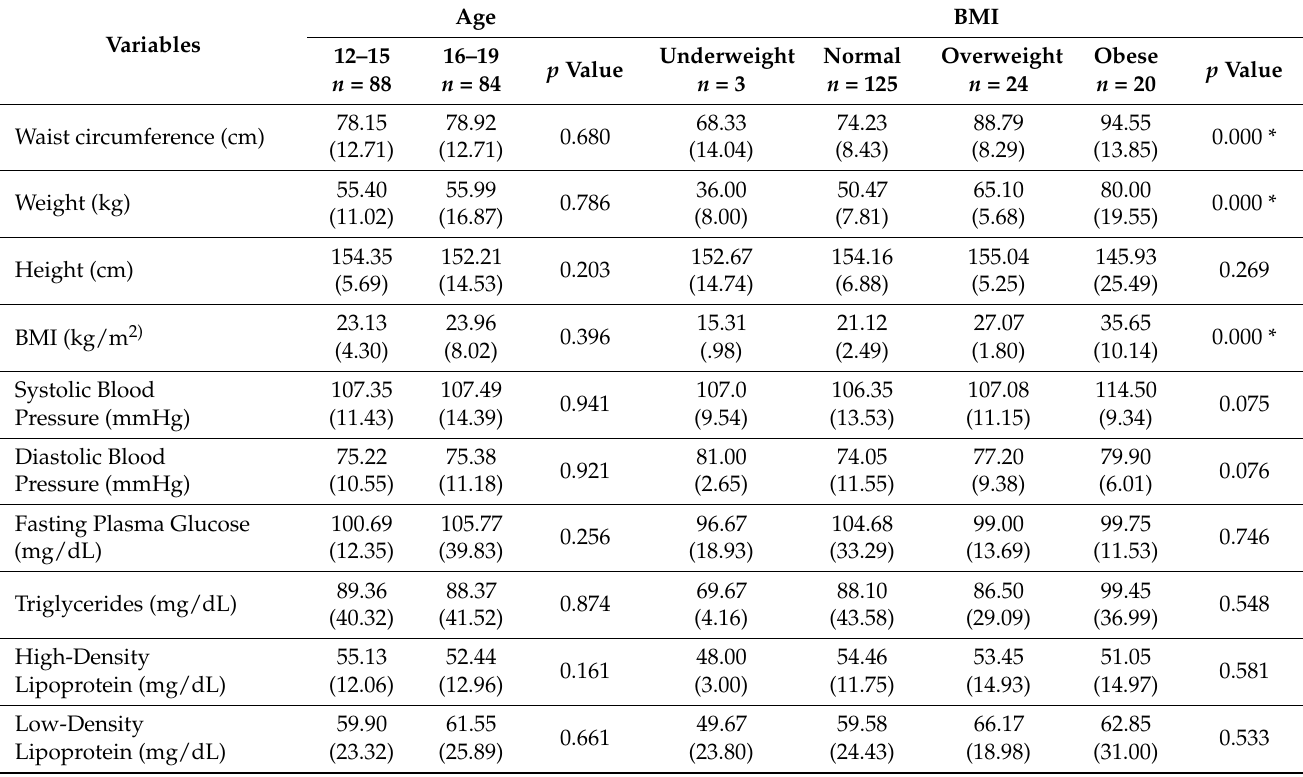
Table 1. Physical characteristics and MS variables differences when stratified according to age and